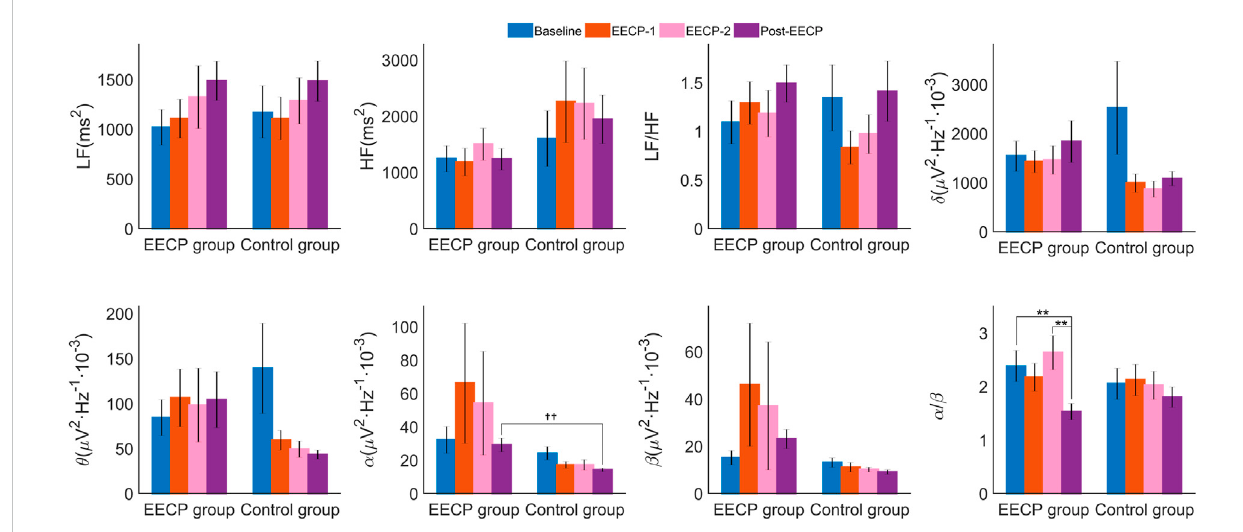
FIGURE 4 Power spectral density (values are mean ± SEM) of heart rate variability (HRV) and electroencephalography (EEG) in active EECP and sham control groups before, during, and after two sessions of 30 minute-EECP. LF, low frequency (HRV frequency band 0.04 – 0.15 Hz); HF, high frequency (HRV frequency band 0.15 – 0.40 Hz); δ , Delta frequency band of EEG (0.5 – 4) Hz; θ , Theta frequency band of EEG (4 – 7) Hz; α , Alpha frequency band of EEG (8 – 13) Hz; β , Beta frequency band of EEG (14 – 30) Hz. p -values for within-group or inter-group comparisons were tested by two-way repeated